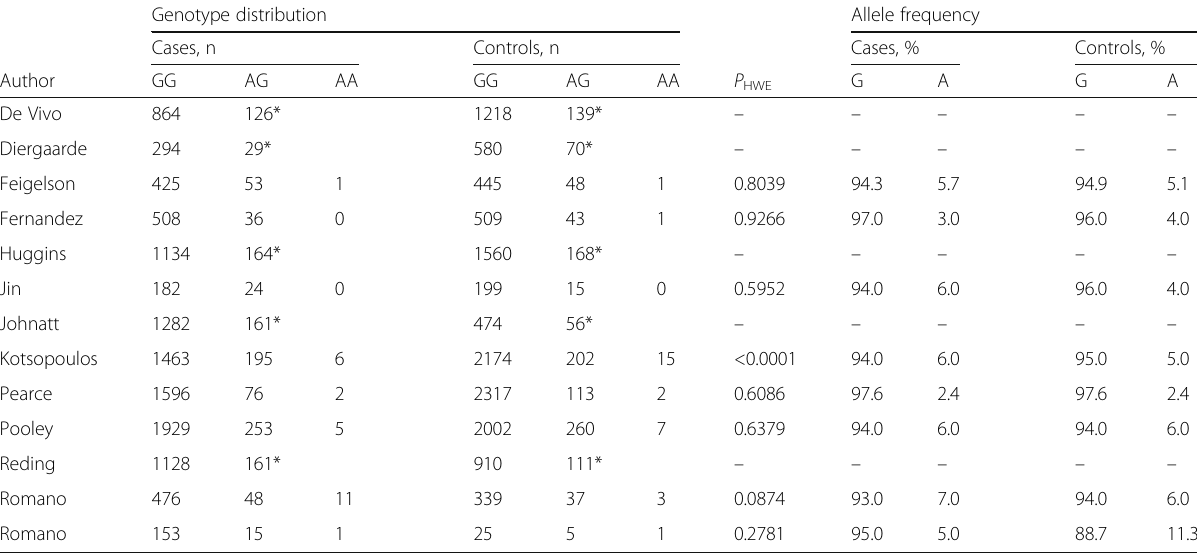
Table 2 Distribution of genotype and allele frequencies of the PGR + 331G/A variation Genotype distribution